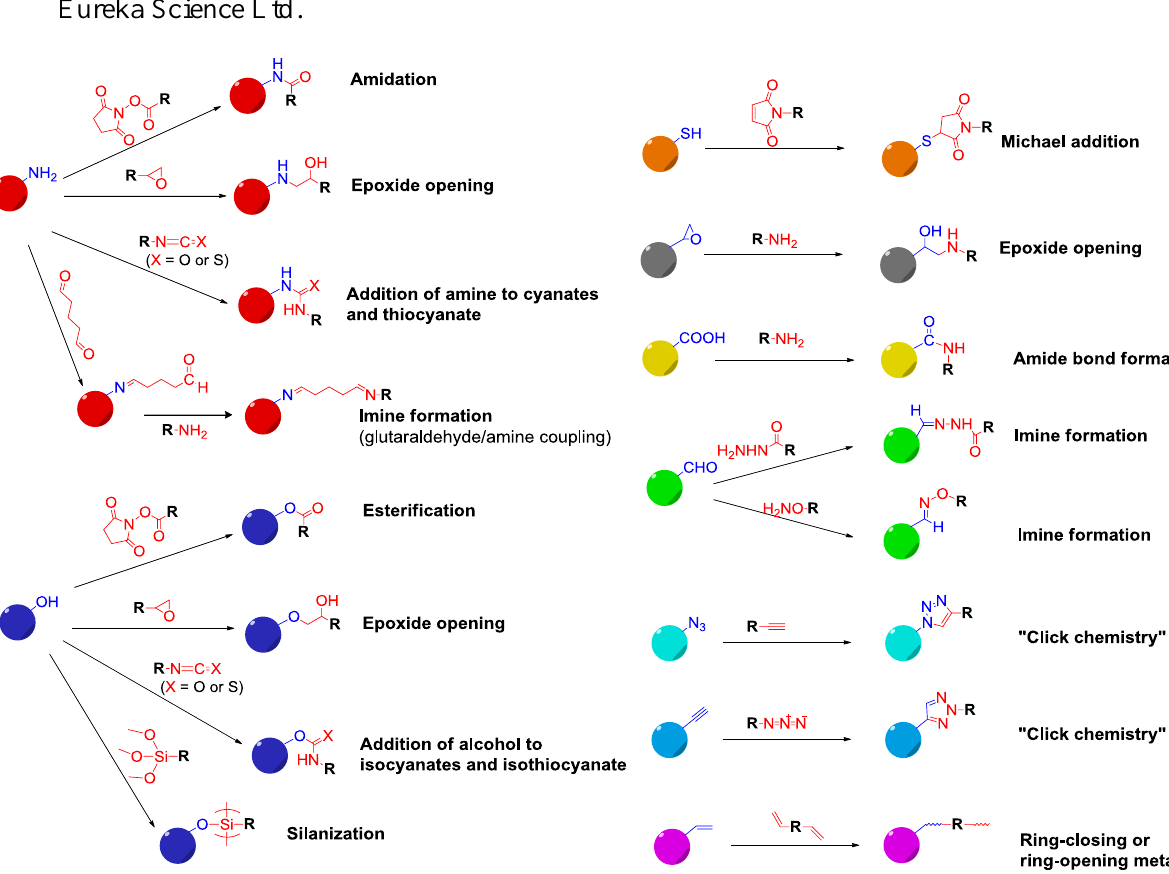
Figure 4. Main strategies for covalent post-functionalization of nanoparticles. Reproduced with permission from [20], partially based on Erathodiyil and Ying [40]. Copyright 2013, Eureka Science